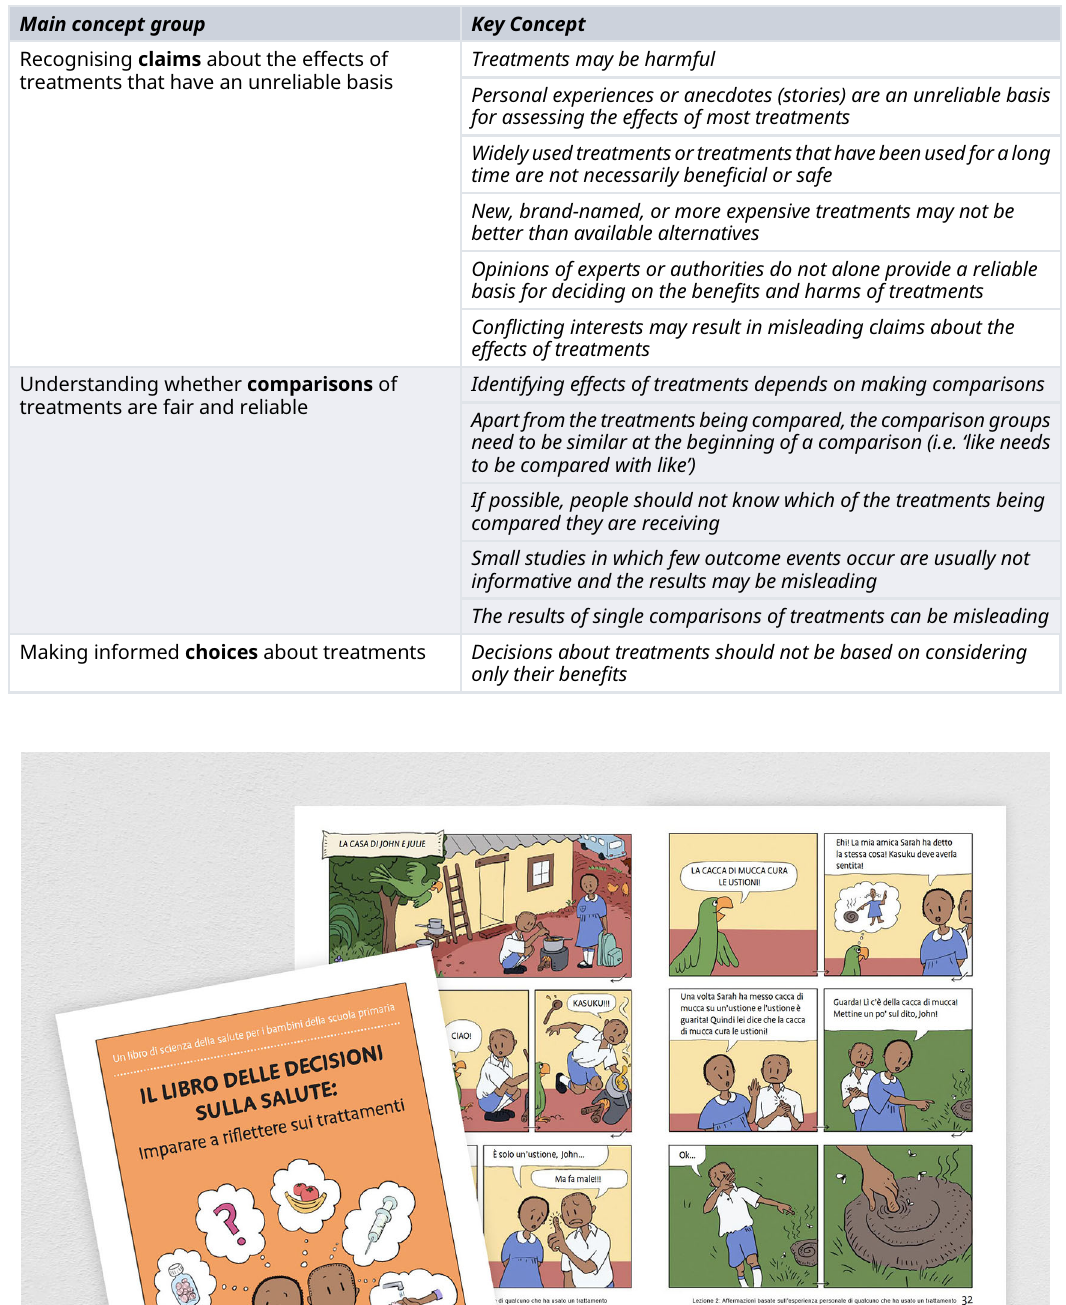
Table 1. The 12 Key Concepts that are taught in the IHC primary school resources.